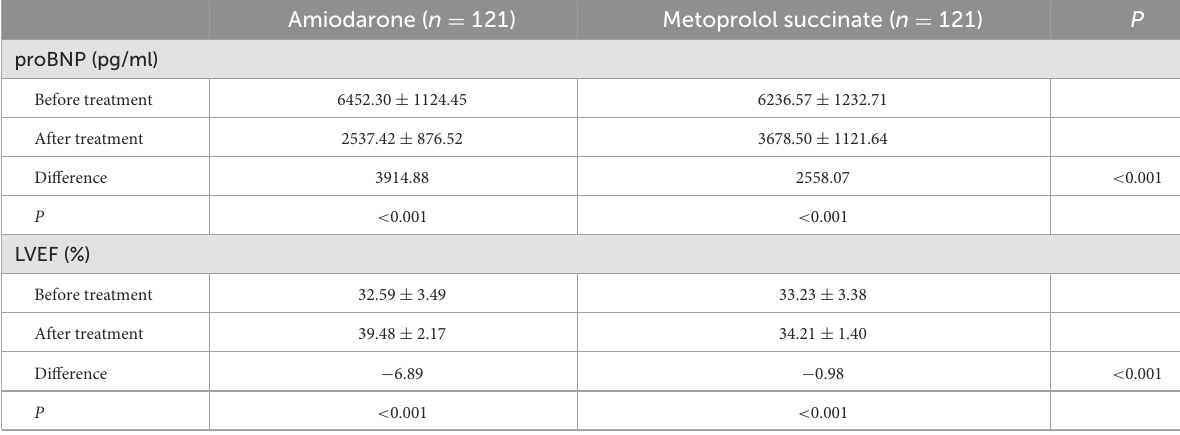
TABLE 3 Comparison of proBNP and LVEF between two groups.